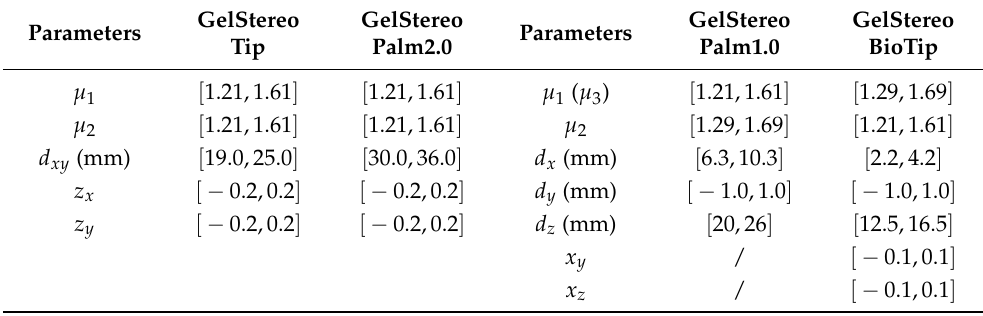
Table 3. Parameter ranges of the GelStereo-type sensors used for optimization.